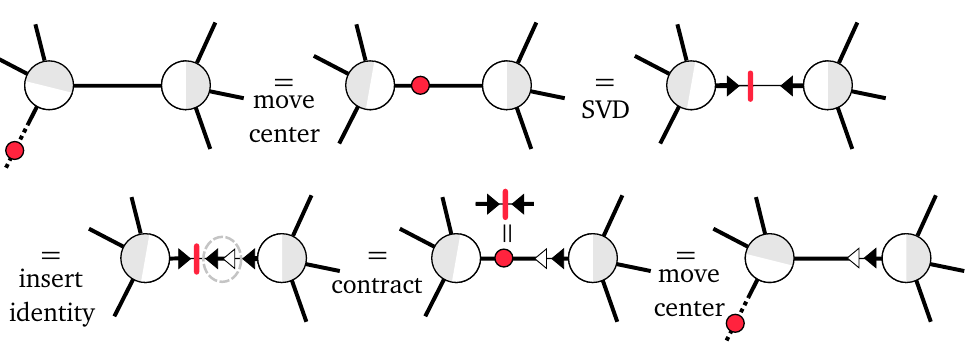
Figure 30: Proof that pairs of isometries W † W act indeed as link-local gauges in the transformation from unitary- to canonical gauge (see also Fig. 29(b)): In unitary gauge, we first move the center (red) onto the selected virtual link (here depicted with two adjacent nodes as part of a larger TN) and compute its SVD (top left to right). The SVD yields a left-unitary term V and a right-unitary term W with V † V = WW † = 1 , but the commuted products do not yield identities in general. We then insert such an identity (here WW † ), restore the center matrix, and move it back to its original position (bottom left to right). This leaves the gauges W † W inserted on the link, while none of the steps changed the network state. The same is true for an insertion of VV †